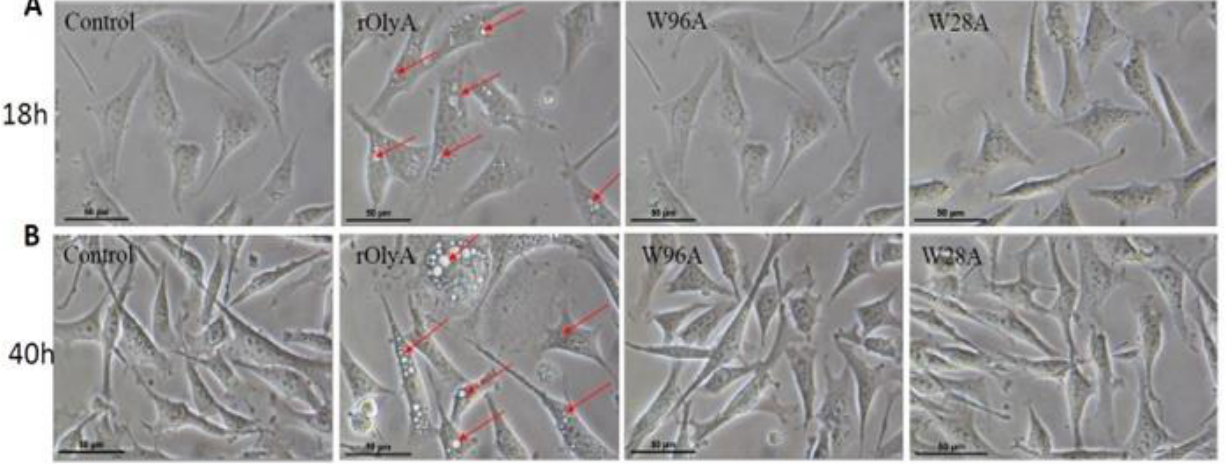
Figure 2. Effect of rOlyA on HIB-1B preadipocytes. Light microscopic imaging (40 after incubation with rOlyA and its mutants for 18 h ( A ) and 40 h ( B ) post-treatment. HIB-1B preadipocytes were incubated with or without 10 µg mL −1 rOlyA, W28A and W96A for 18 h and 40 h; microscopic images were captured. The red arrows indicate the occurrence of small lipid droplets in the rOlyA- treated group.